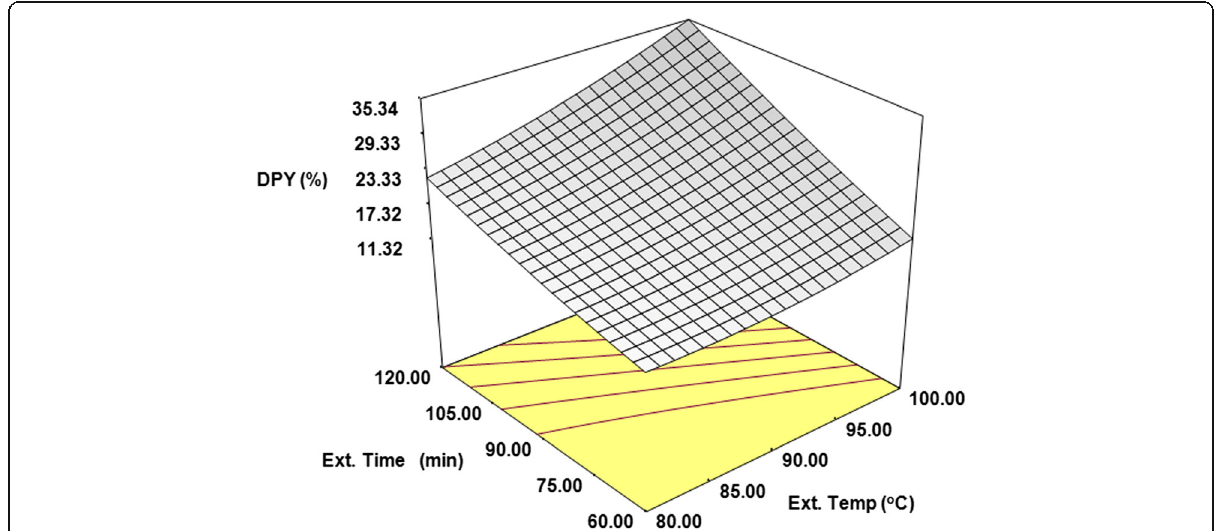
Fig. 2 Response surface plot of the effect of extraction temperature and extraction time on dried pectin